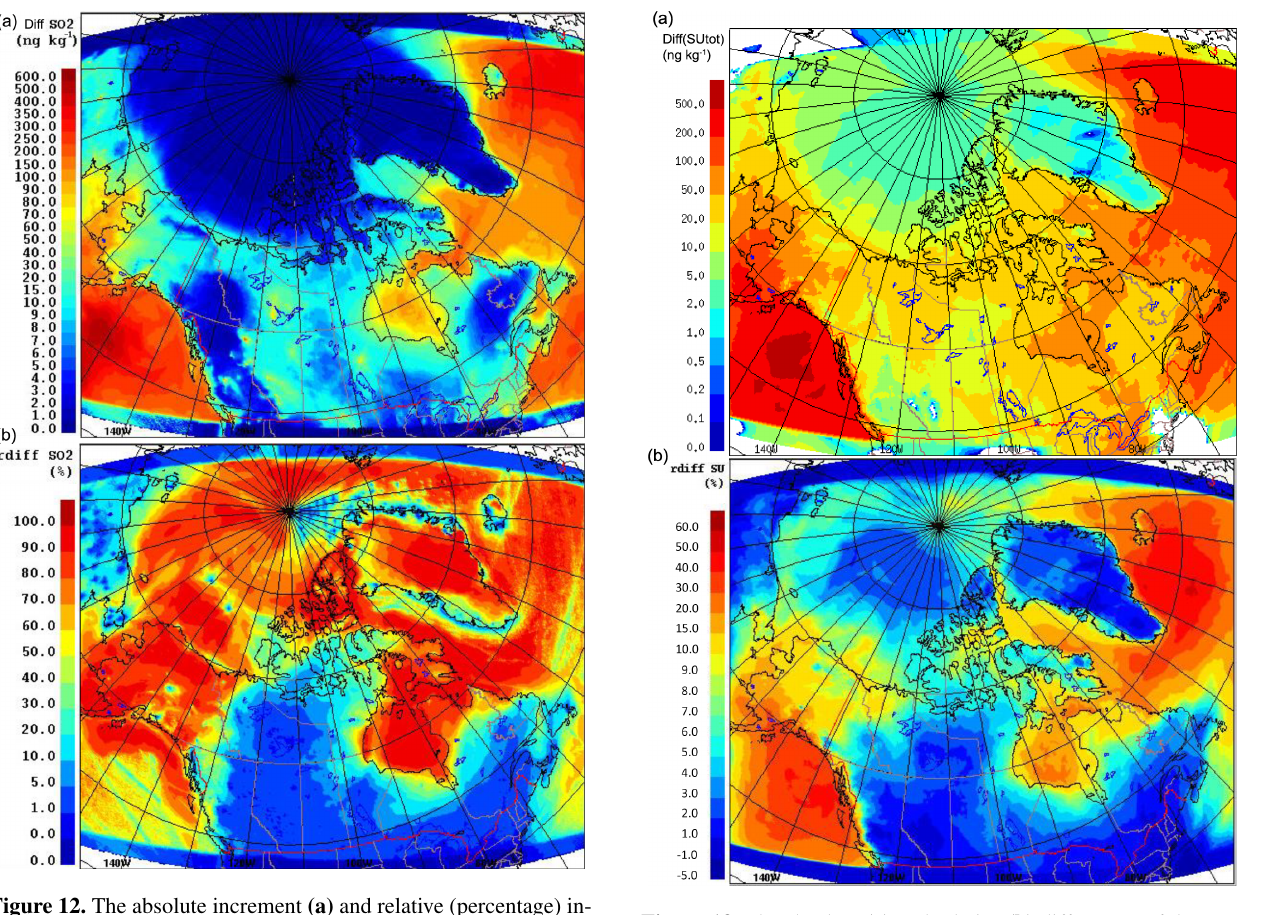
Figure 13. The absolute (a) and relative (b) differences of the non- sea-salt sulfate aerosol concentrations (0.01 to 41µm) with and without DMS(g) during July